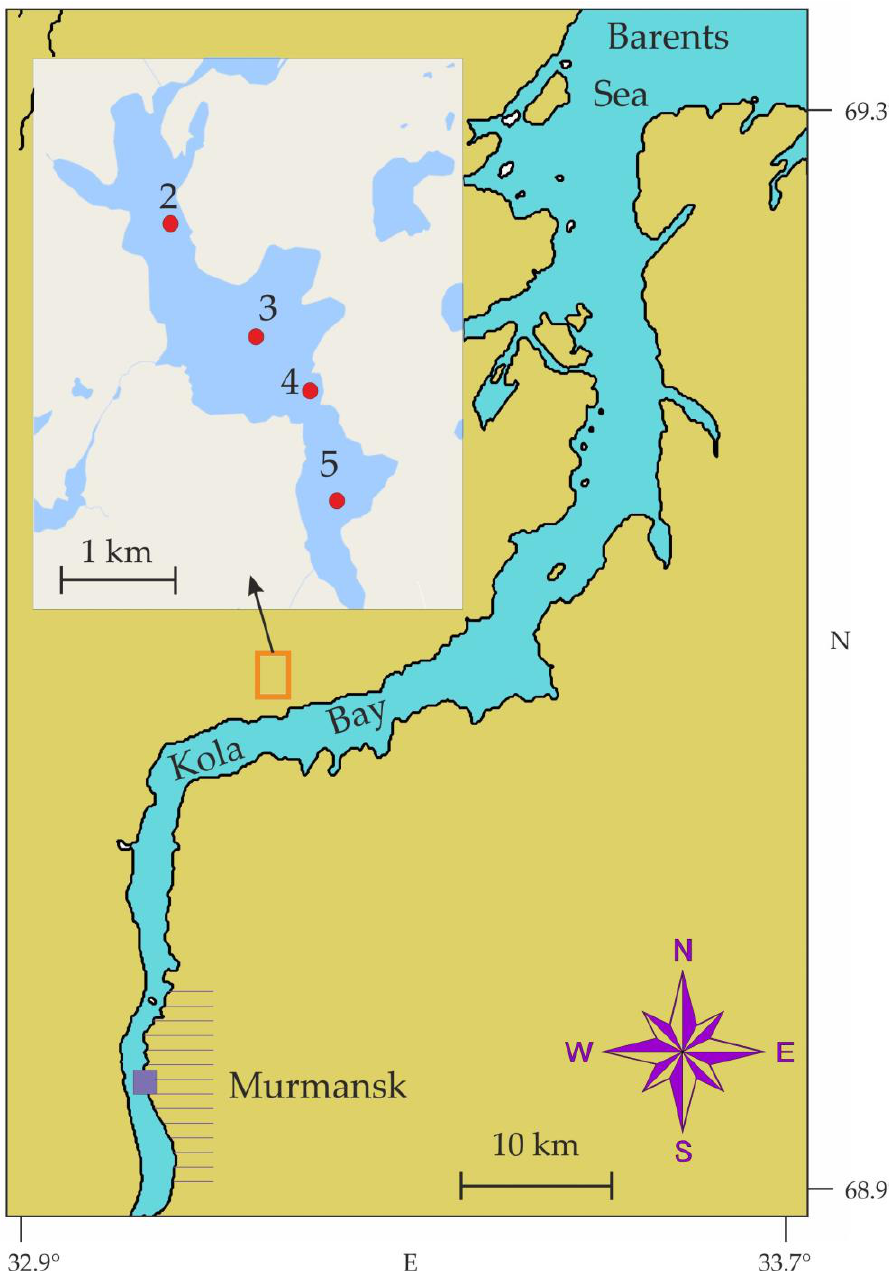
Figure 2. Location of zooplankton sampling stations (red circles) in Lake Kulonga, March 2016. Purple square indicates location of Murmansk.